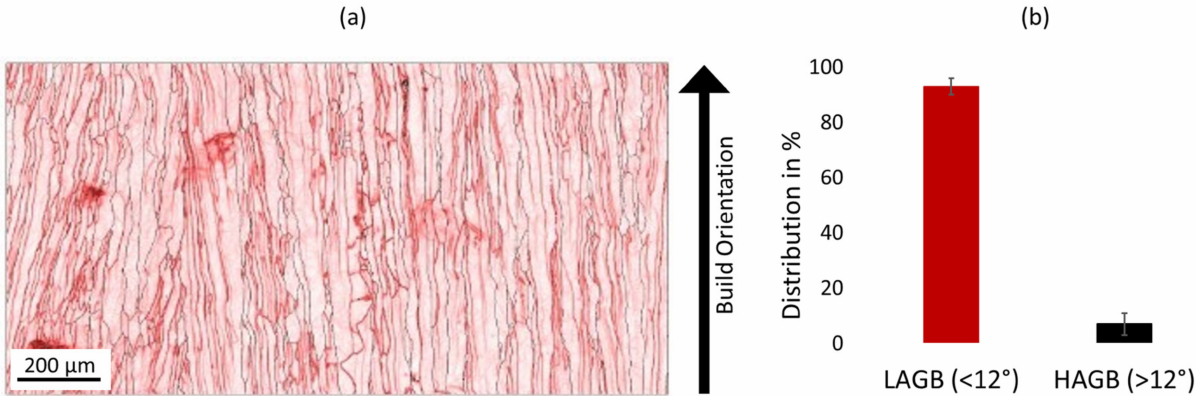
Figure 5. ( a ) EBSD Grain boundary angles of Cu sample with E A 8.64 J/mm 2 (High angle grain boundaries = Black lines, >10 ◦ ; Low angle grain boundaries = Red lines, <10 ◦ ); ( b ) Distribution of LAGBs and HAGBs from EBSD scan shown in ( a